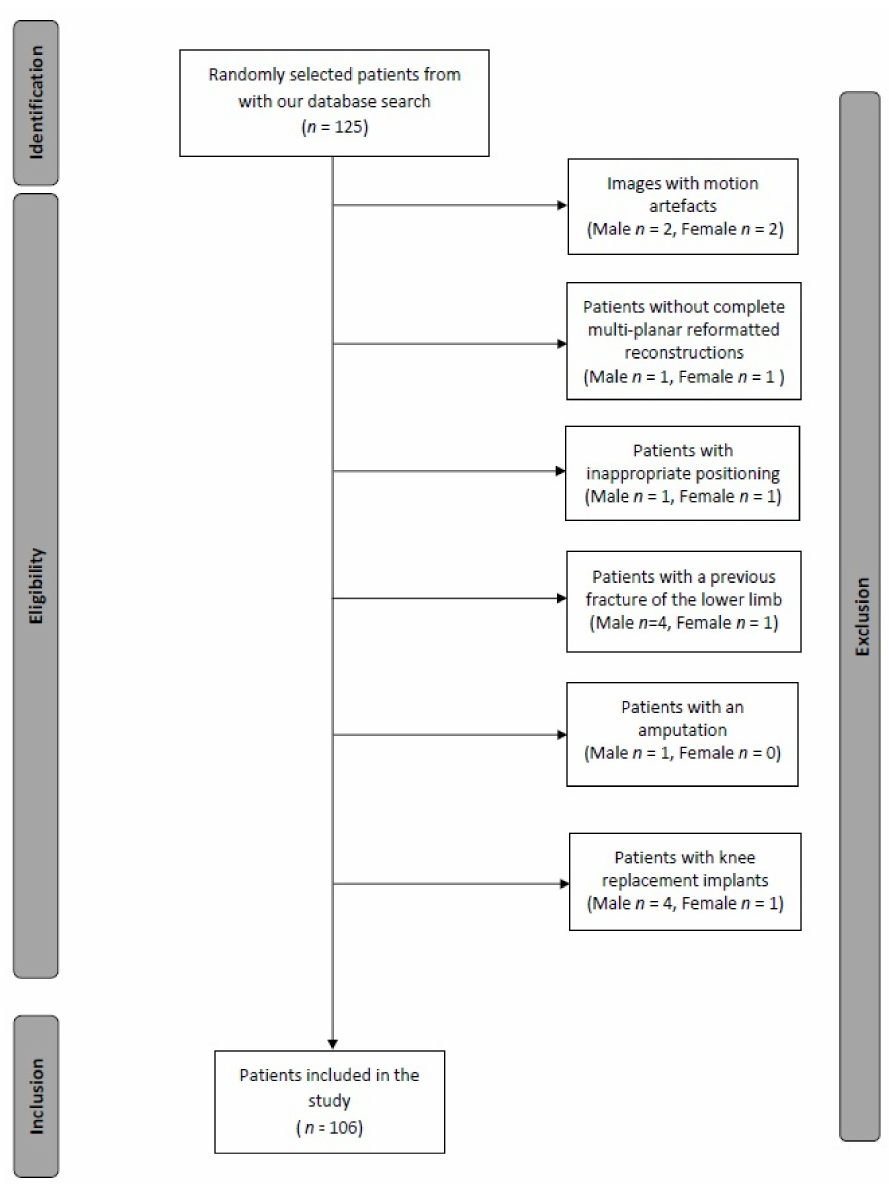
Figure 1. Flow diagram of the inclusion / exclusion